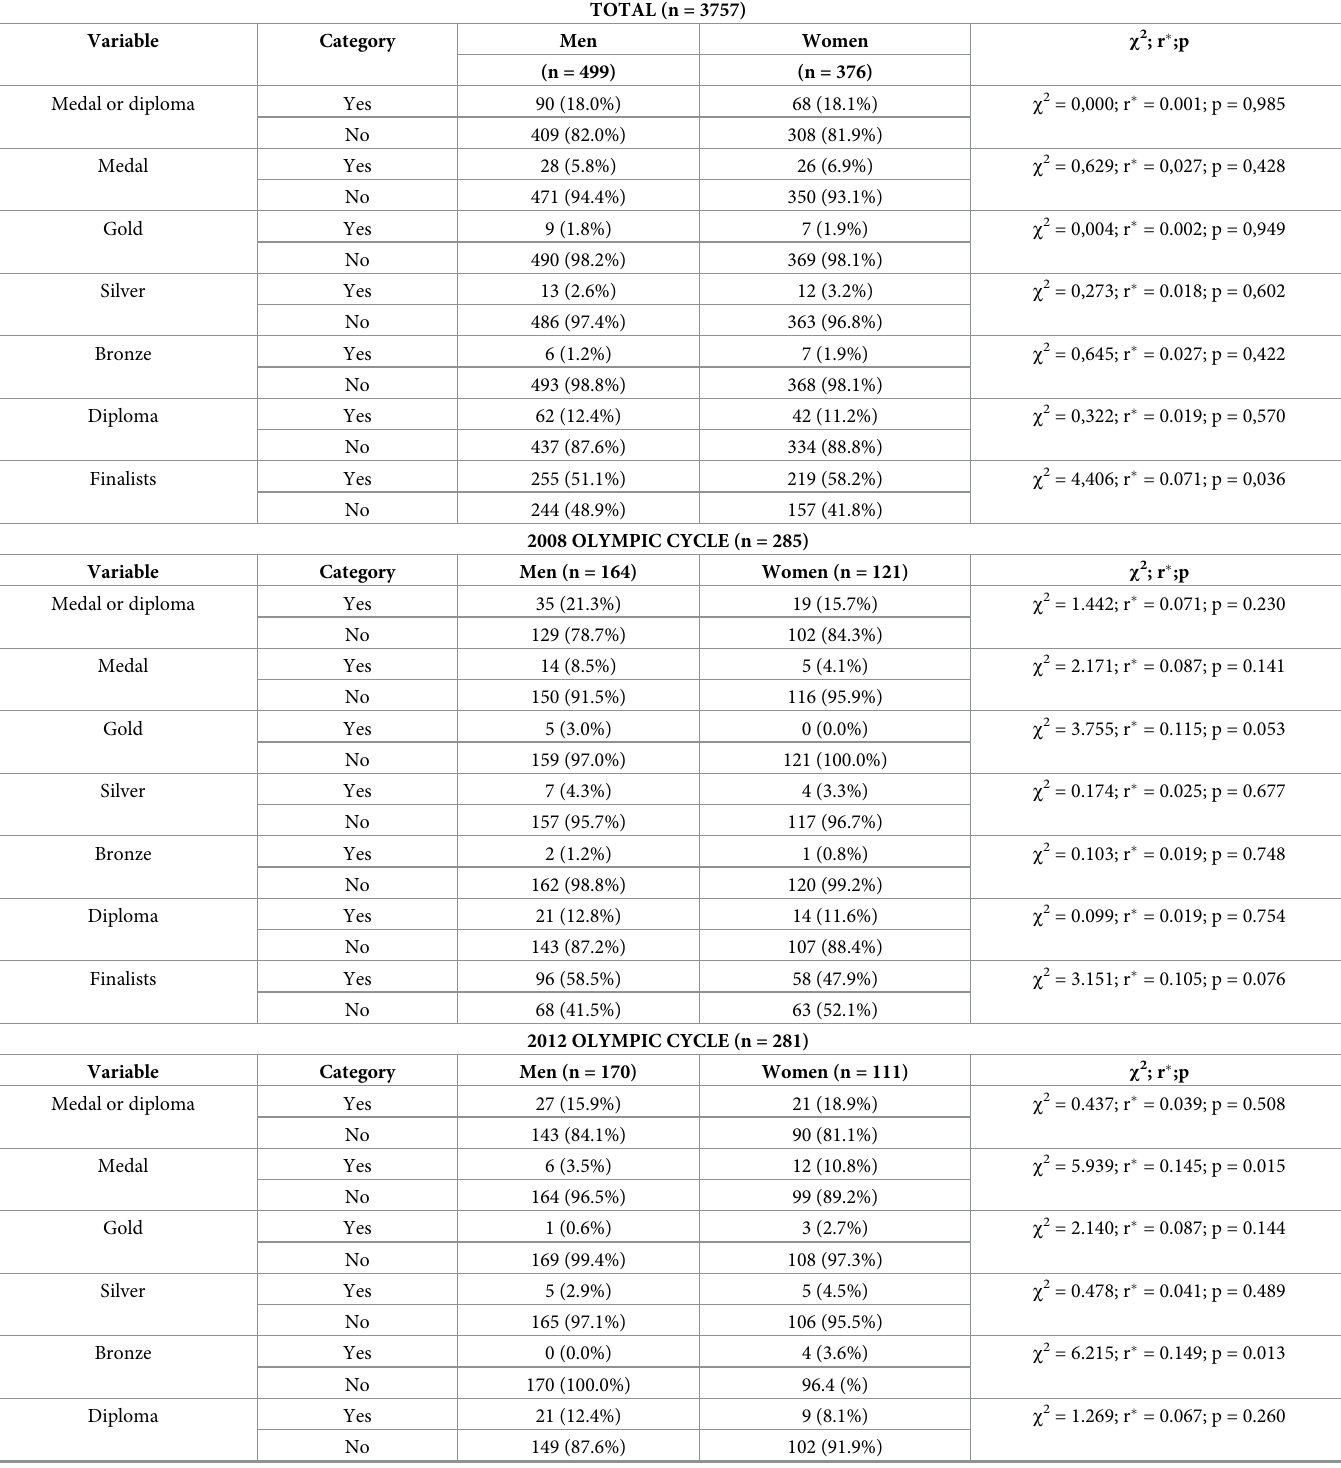
Table 2. Differences between male and female Olympians in medals, diplomas and finalists overall and by Olympic